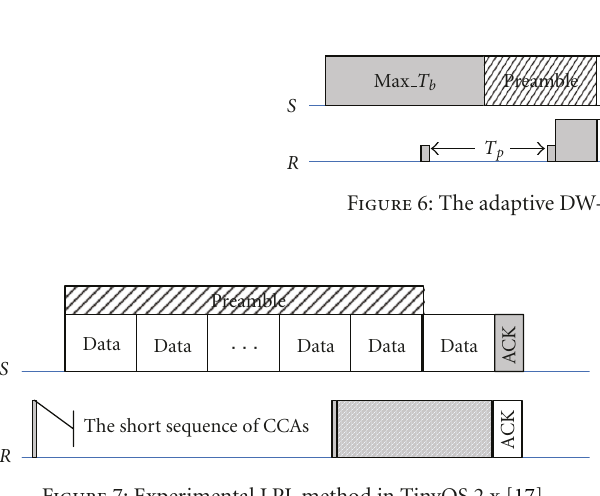
For outgoing packets, DW-LPL module first decides which transmission mode will be used according to the destination ID. If the ID is broadcast address, the packet is tried in TIM context. Otherwise, the packet is tried in RIM context. As described in Section 4, for adaptive listening, if the transmission in RIM context fails then the context transition from RIM to TIM is followed with the unicast packet with a special